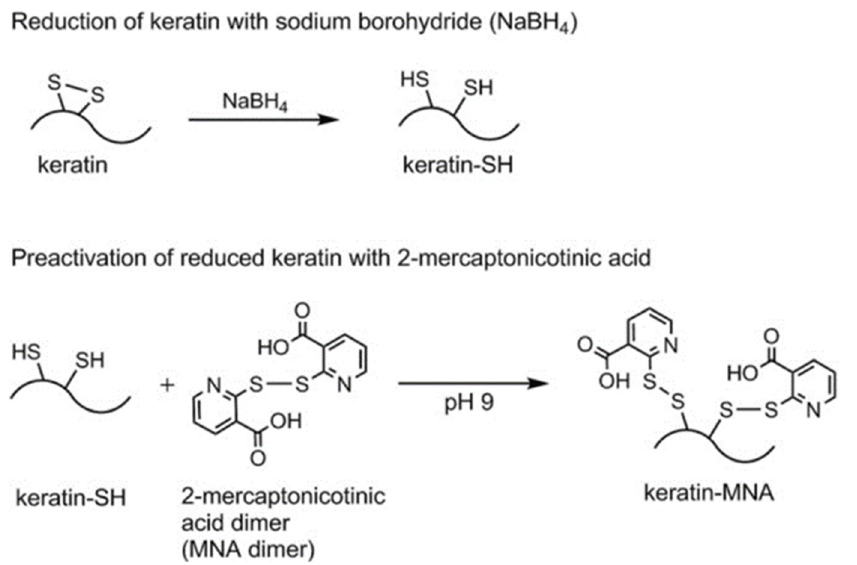
Figure 8. Reduction of keratin, to generate keratin-SH, and subsequent reaction with oxidized MMA to generate keratin-MMA via a thiol-disulfide exchange reaction Reprinted with permission from [39]. Copyright (2019) Elsevier B. V.